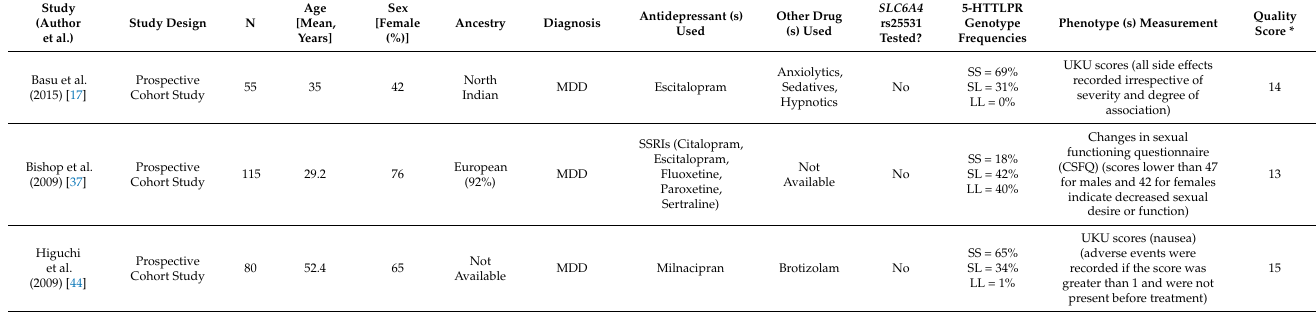
Random-effects pooled ORs showed no significant associations between the three 5-HTTLPR genetic models and antidepressant tolerability (Supplementary Figure S1), and evidence of publication bias was detected when comparing the L vs. S genotypes (p = 0.047) and the LL vs. SS genotypes (p = 0.028) but not the LL/LS vs. SS genotypes (p = 0.061) in the combined study populations (Supplementary Figure S2). Stratified analyses of only SSRI treatment studies, however, showed that L allele carriers reported fewer ADRs relative to SS carriers (LL vs. SS: OR = 0.59, 95% CI = 0.42–0.82, p = 0.002; LL/LS vs. SS: OR = 0.64, 95% CI = 0.49–0.84, p = 0.001) (Figure 3). Due to the limited number of studies and data, stratification by non-SSRI use was not conducted. Furthermore, when stratified by ancestry, European L carriers taking SSRIs reported fewer ADRs to S carriers (L vs. S: OR = 0.79, 95% CI = 0.64–0.99, p = 0.045; LL/LS vs. SS: OR = 0.58, 95% CI = 0.43–0.78, p < 0.001) (Figure 4). No associations were detected when the analyses were restricted to studies conducted in the Japanese population (L vs. S: OR = 0.953, 95% CI = 0.51–1.76,